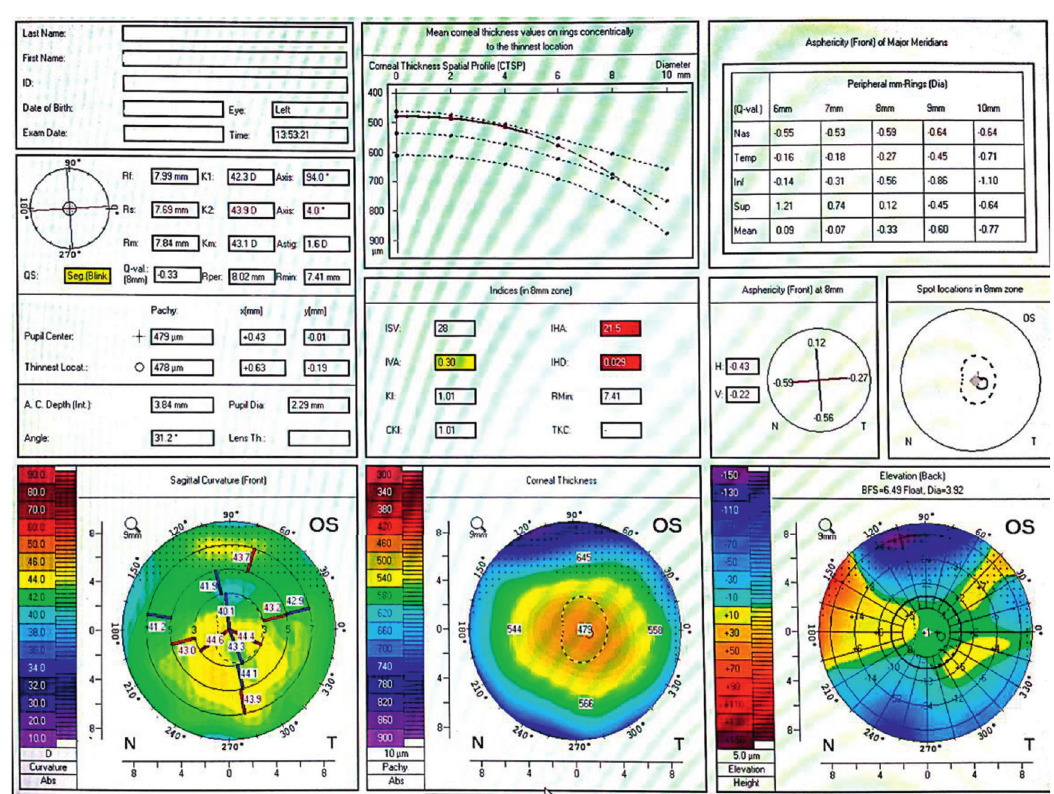
Figure 2: Pentacam of the left eye of a patient in group 2 (keratoconus